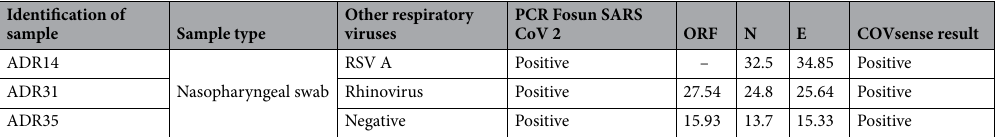
Table 6. Positive samples that were previously categorized as negative with diverse cycle threshold values were re-tested by RT-qPCR.